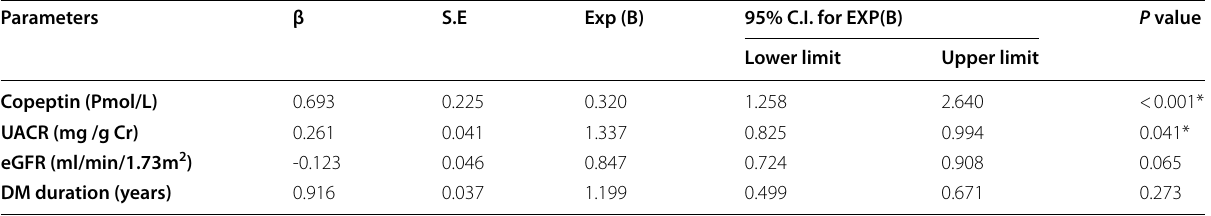
Table 2 Multivariate regression analysis of predictors of nephropathy among type 2 diabetic